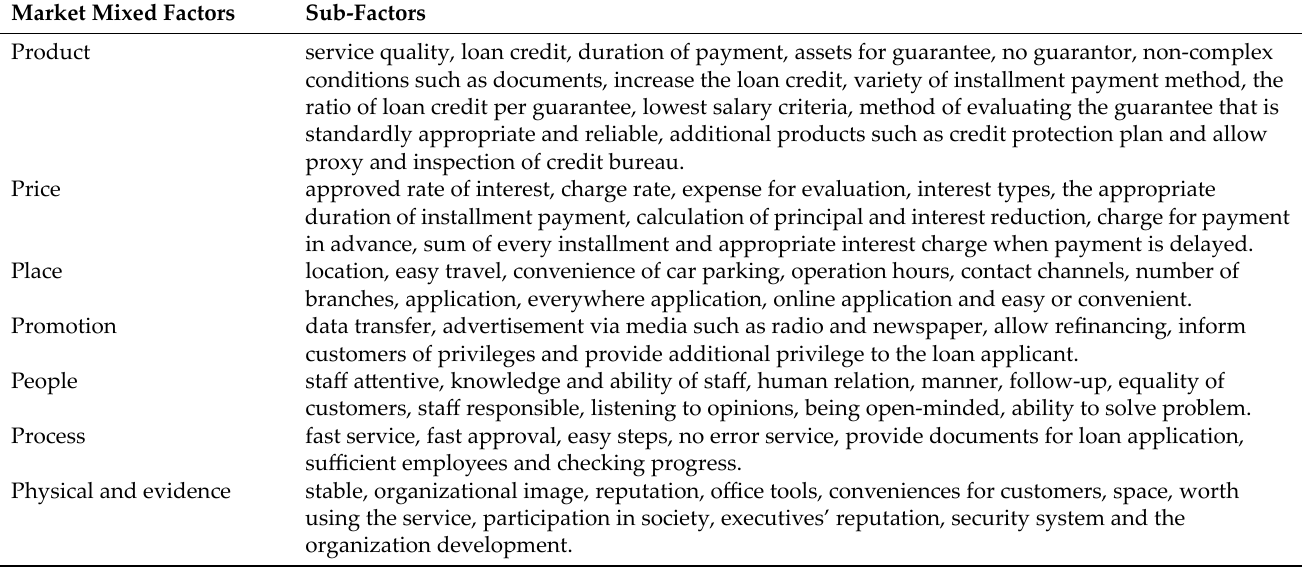
Table 1. Market mixed